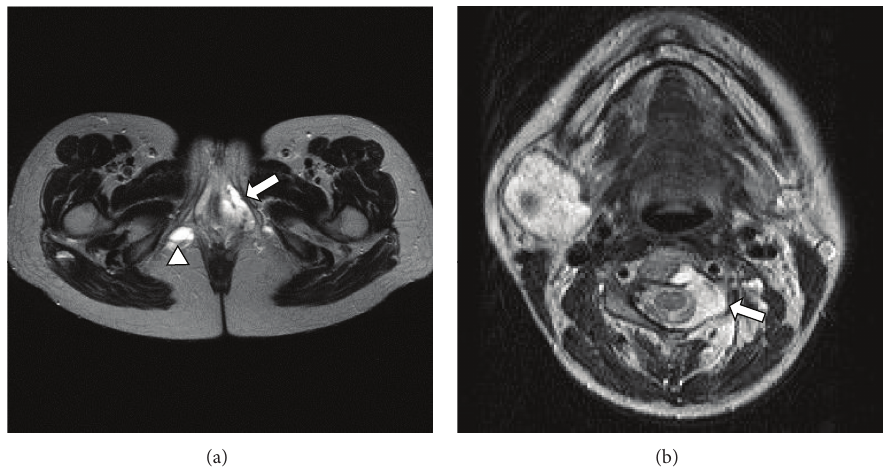
Figure 2: T2-weighted pelvic and brain magnetic resonance imaging (MRI). (a) Pelvic MRI demonstrating venous malformations in the left vulva (arrow) and right levator ani (arrow head). (b) Brain MRI exhibiting spinal epidural venous malformations